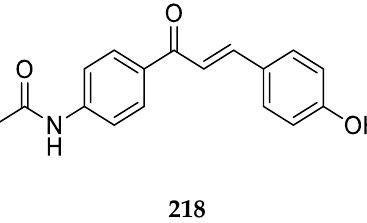
Figure 68. Chemical structure of N -acetyl-4-aminochalcone derivative with substitution on ring B.